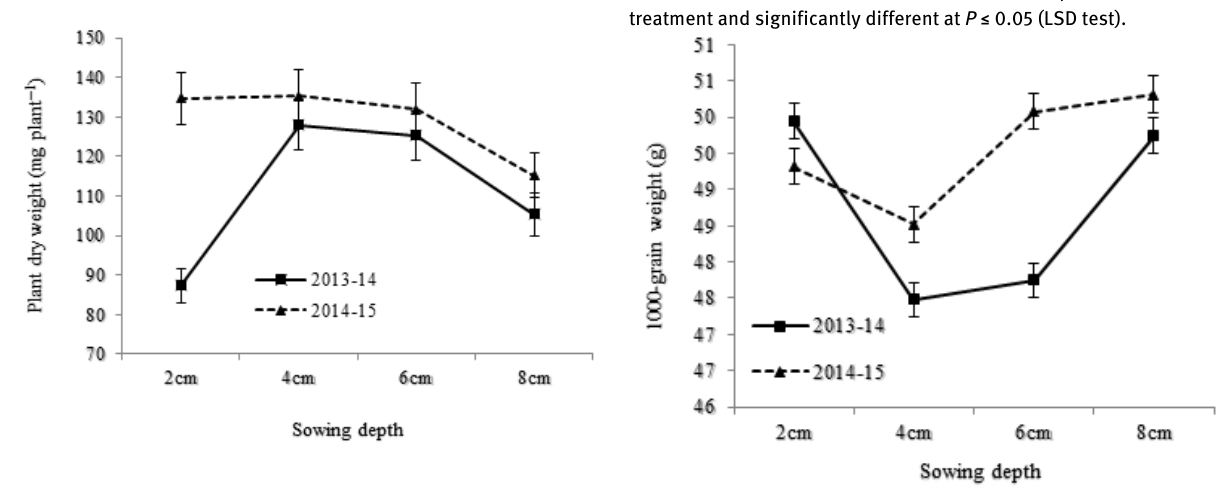
Figure 5: Seminal roots’ dry weight (mg plant -1 ) as affected by sowing depth of wheat recorded at 10 DAS. Mean (±SD) was cal- culated from three replicates for each treatment and significantly different at P ≤ 0.05 (LSD test).